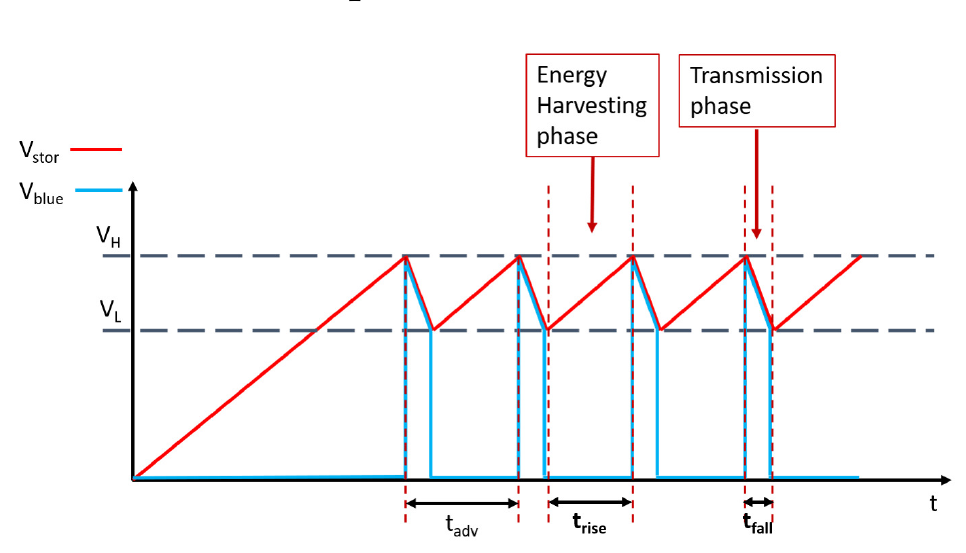
Figure 2. Functional evolution of the voltage V stor and V blue vs.